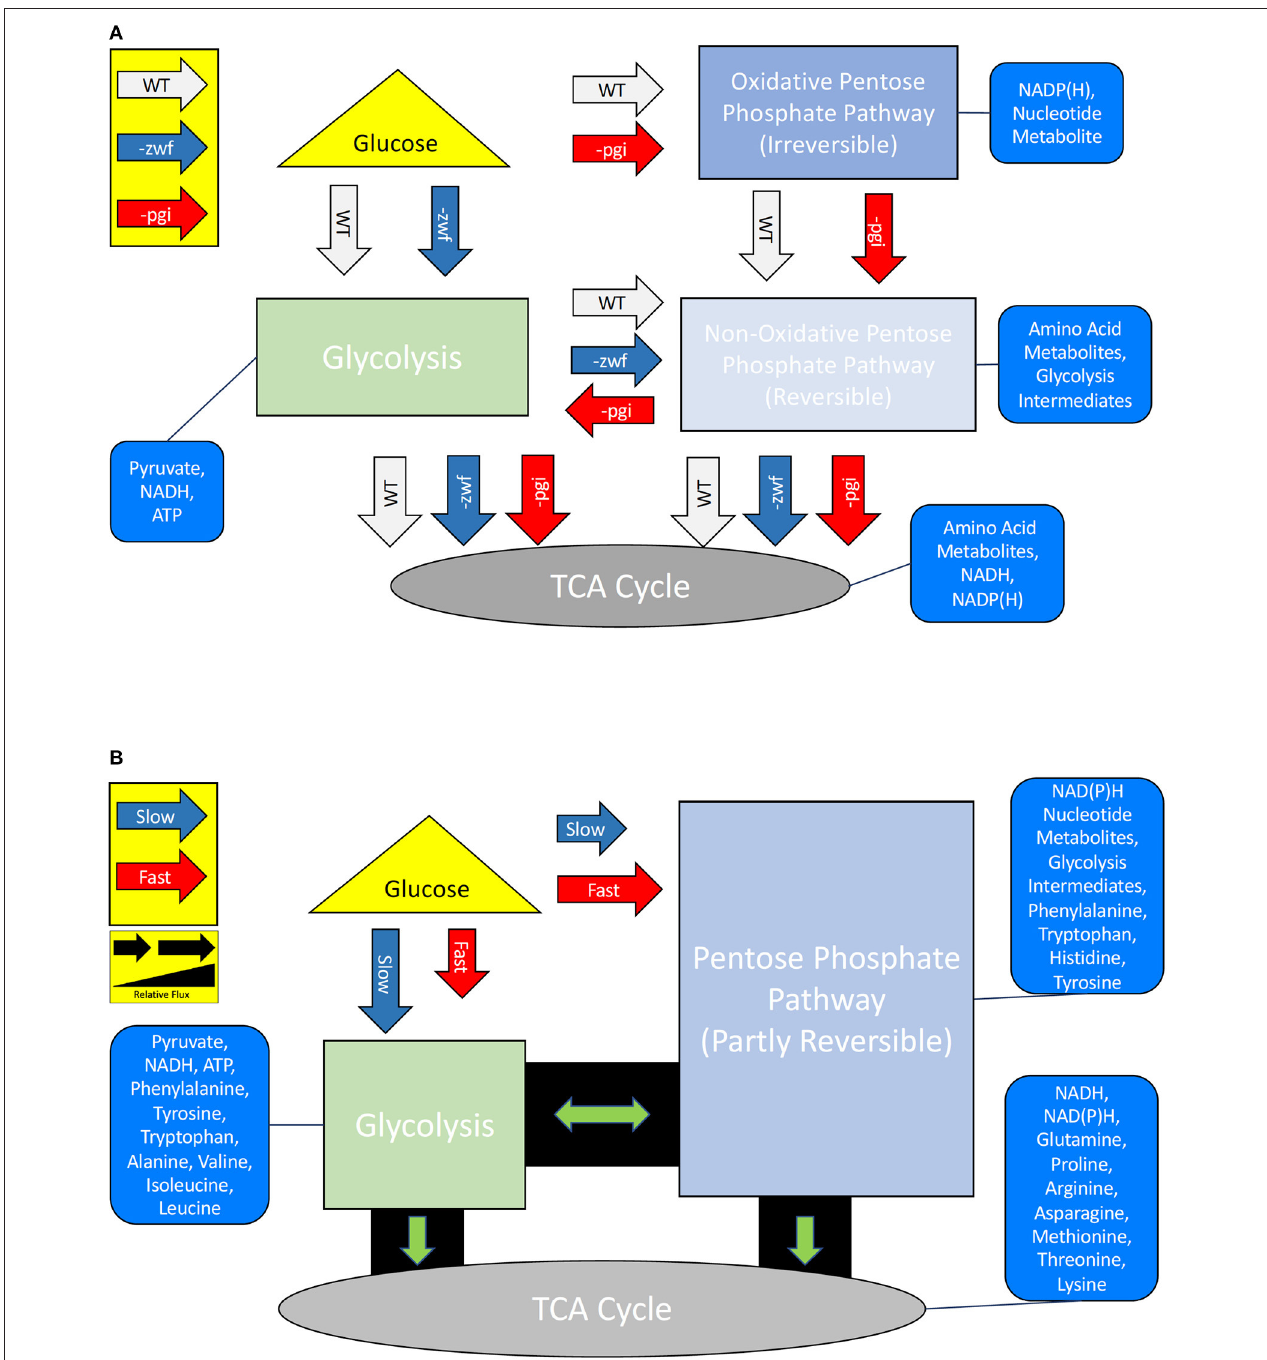
FIGURE 1 | (A) Simplified central carbon metabolisms and products for Escherichia coli MG1655 wild type (WT) strain and two mutant strains –pgi and –zwf . (B) Simplified central carbon metabolisms and products of the WT strain grown under fast or slow growth rate conditions. The altered fluxes for the (non-)oxidative pentose phosphate pathway are well characterized for the mutants, but poorly understood under different growth rates. Relative arrow length represents expected relative flux differences (i.e., a shorter arrow is less flux).